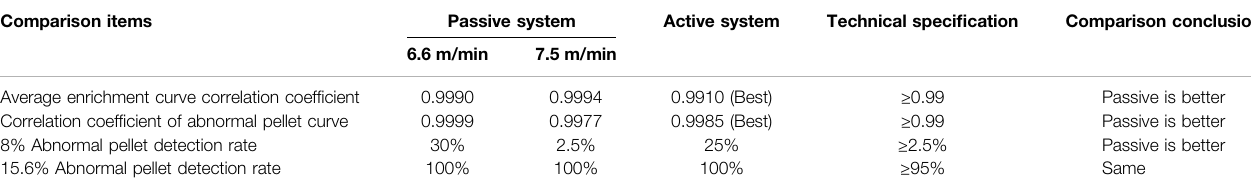
TABLE 4 | 4.95% Standard rod calibration